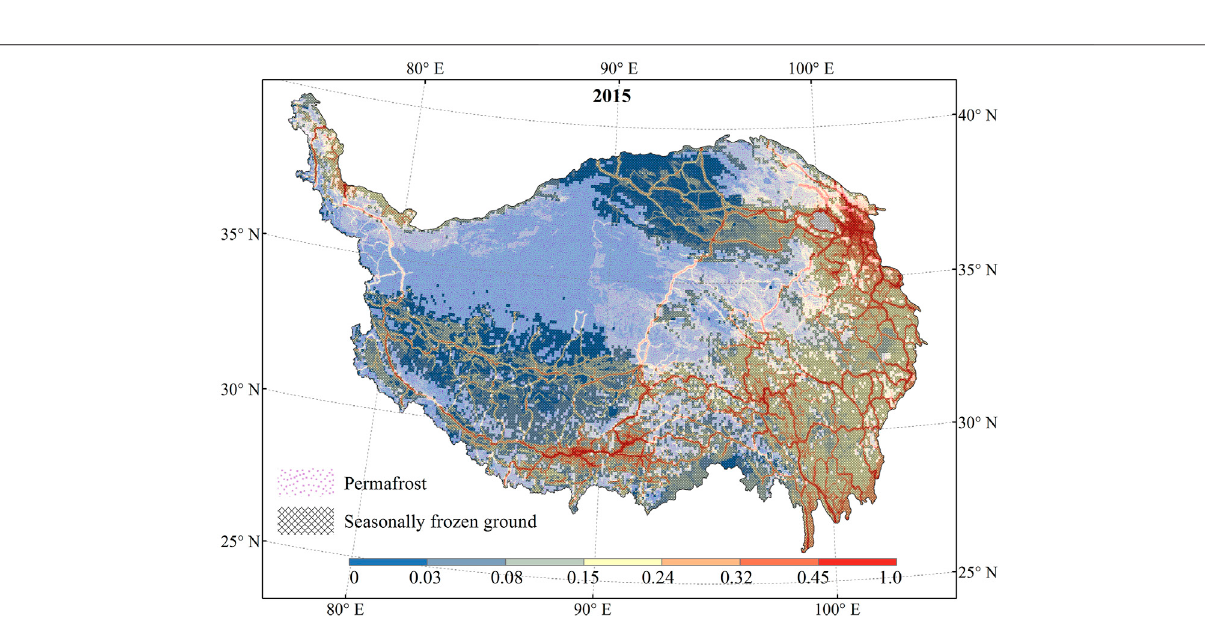
FIGURE 4 | Spatial distribution of total human activity intensity in 1995, 2005, and 2015 on the Qinghai – Tibet Plateau.